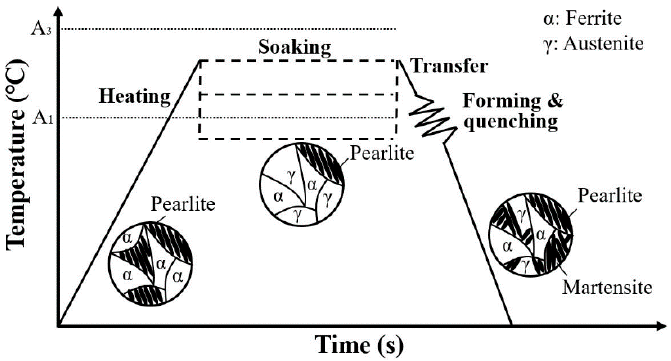
Figure 5. Schematic illustration of hot stamping process with lower heating temperature for Mn-B steel and evolution of microstructure at each stage.